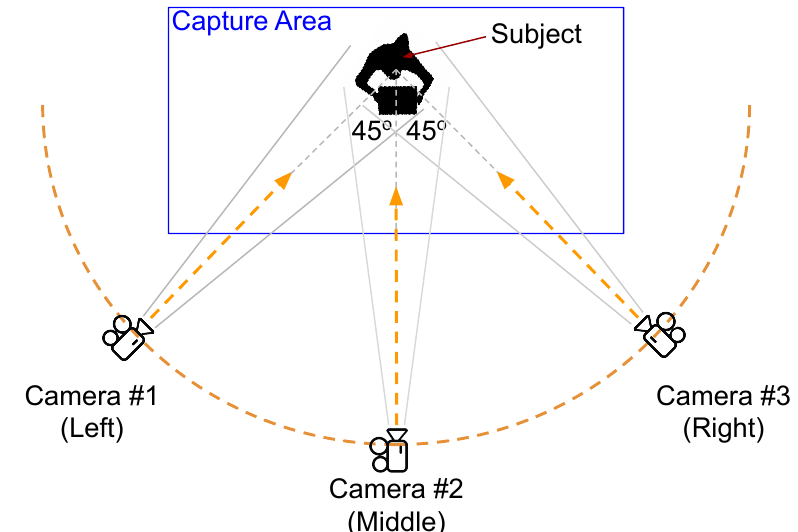
Figure 5. The camera setup that has been used for the creation of the PKU-MMD dataset. Cameras #1, #2, #3 correspond to L , M , R , respectively (see Section